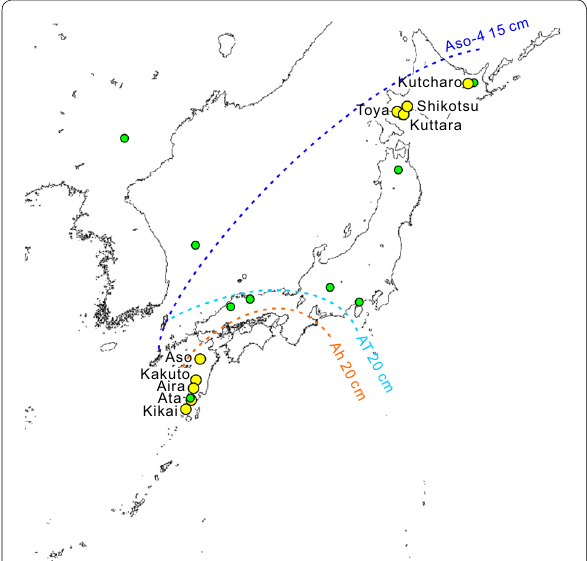
Fig. 1 Locations of volcanoes that have produced VEI > 6 eruptions during the late Pleistocene and Holocene in and around the Japanese archipelago. Yellow circles show the sites of VEI 7 eruptions. Green circles indicate the volcanoes which produced VEI 6 class eruptions. Representative isopach lines of three co-ignimbrite ash falls (Aso-4 at ~ 89 ka from Aso caldera, AT erupted at 30 ka from Aira caldera, and Ah erupted at 7.3 ka from Kikai caldera) are